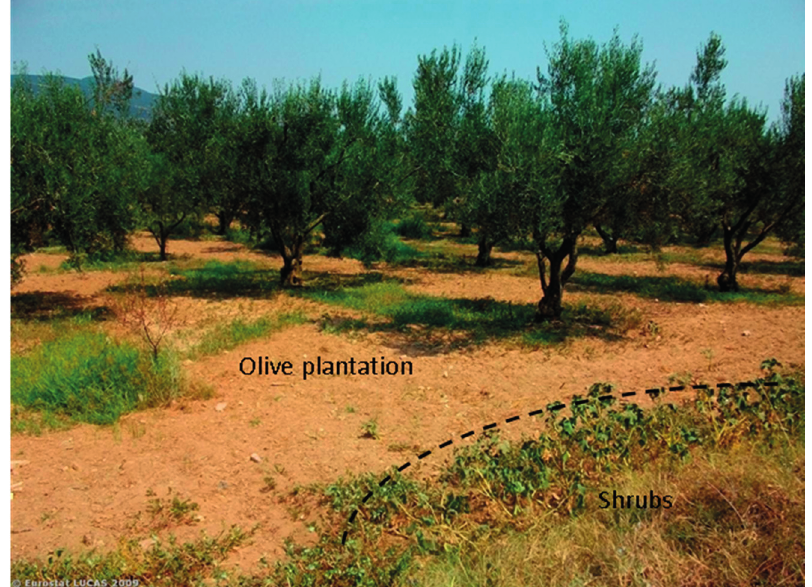
Figure 9. A particular case in Thessaloniki, where the point was classified as “Agricultural land” by WWF Hellas and as “Shrubland without tree cover” (D20) by the LUCAS surveyors, possibly due to the existence of a shrub patch located at the edge of the olive plantation.